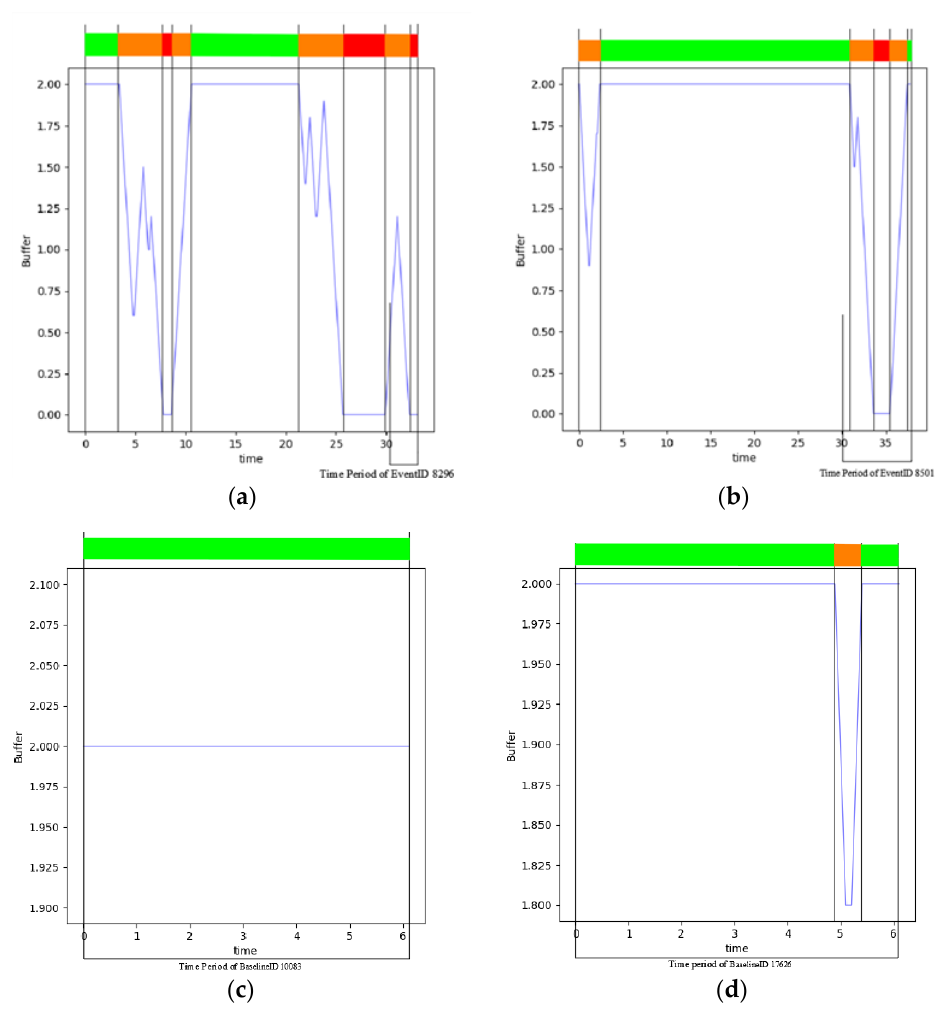
Figure 2. Changes in drivers’ visual buffers and distractions in different IDs: ( a ) EventID 8296 Driver Visual Buffer; ( b ) EventID 8501 Driver Visual Buffer; ( c ) BaselineID 10,083 Driver Visual Buffer; ( d ) BaselineID 17,626 Driver Visual Buffer.